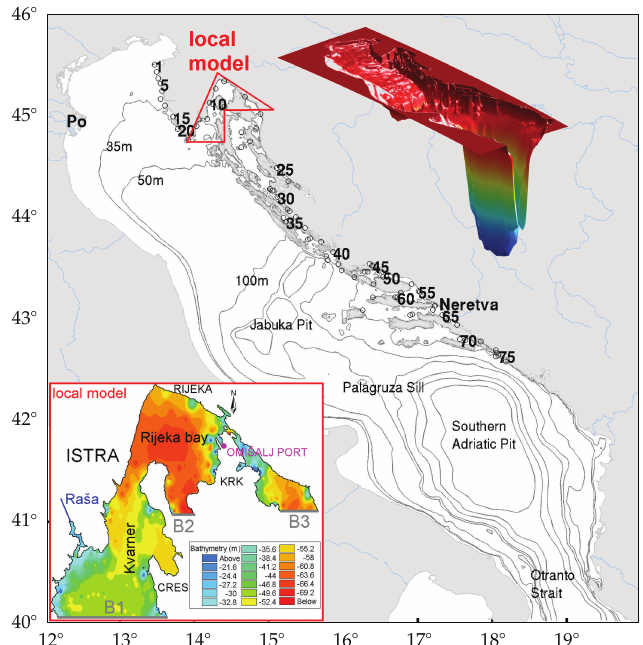
Figure 1: ROMS model spatial domain (cid:4) the whole Adriatic Sea (cid:5) and nested domain of MIKE 3 model for Kvarner, Rijeka Bay, and Vinodol channel area (cid:4) circles indicate positions of CTD stations; B1, B2, and B3 are locations of the open boundaries of local model (cid:5)